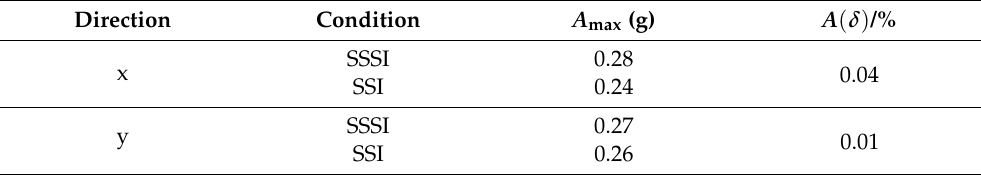
Table 8. Comparison of FRS at different locations of the raft foundation of SSI system and SSSI system.